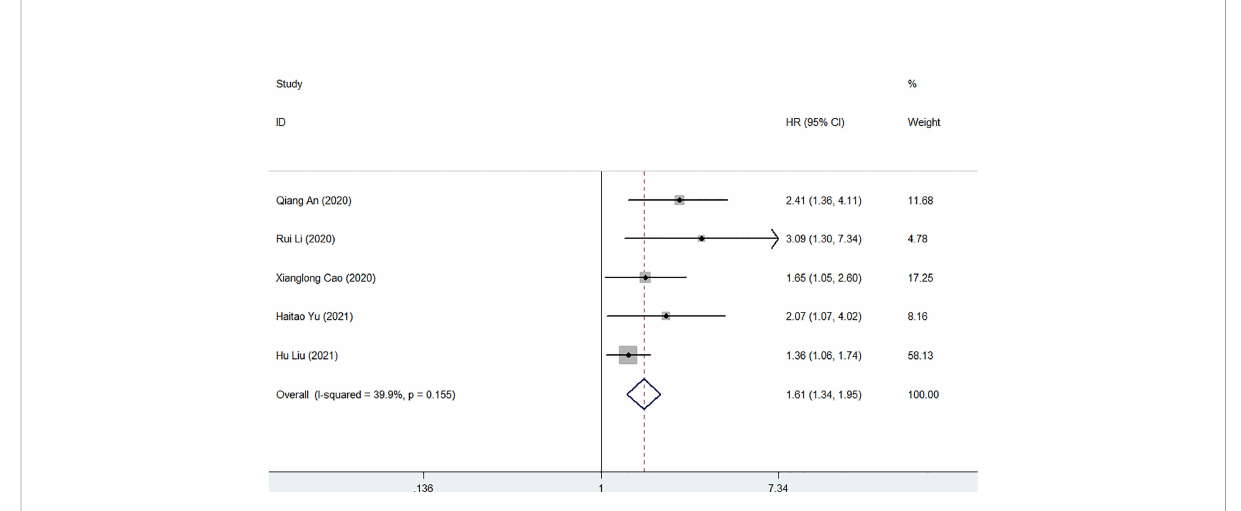
FIGURE 5 Forest plot for the association between FAR and recurrence − free survival.